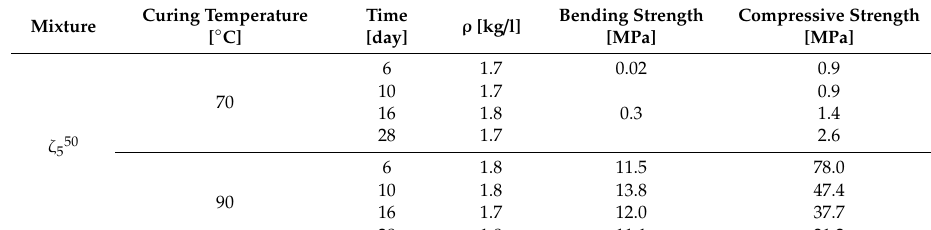
Table 11. Time dependence of density, bending, and compressive strength of AAM prepared with mixture ζ 5 , cured on 70 ◦ C for one day and cured on 90 ◦ C for one day.